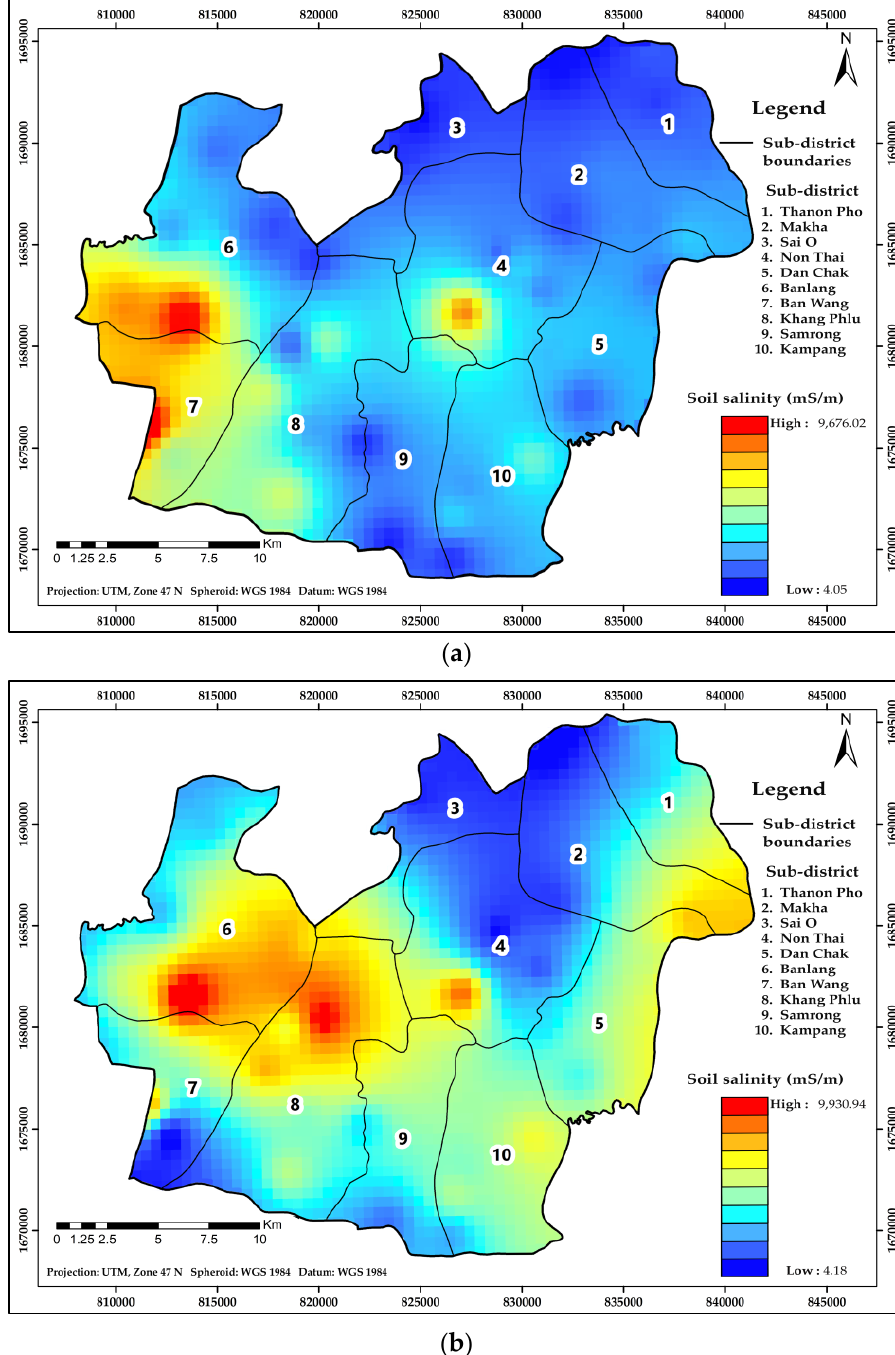
Figure 12. Spatial distribution of soil salinity prediction using RK of two measuring modes: ( a ) HH and ( b ) VV.